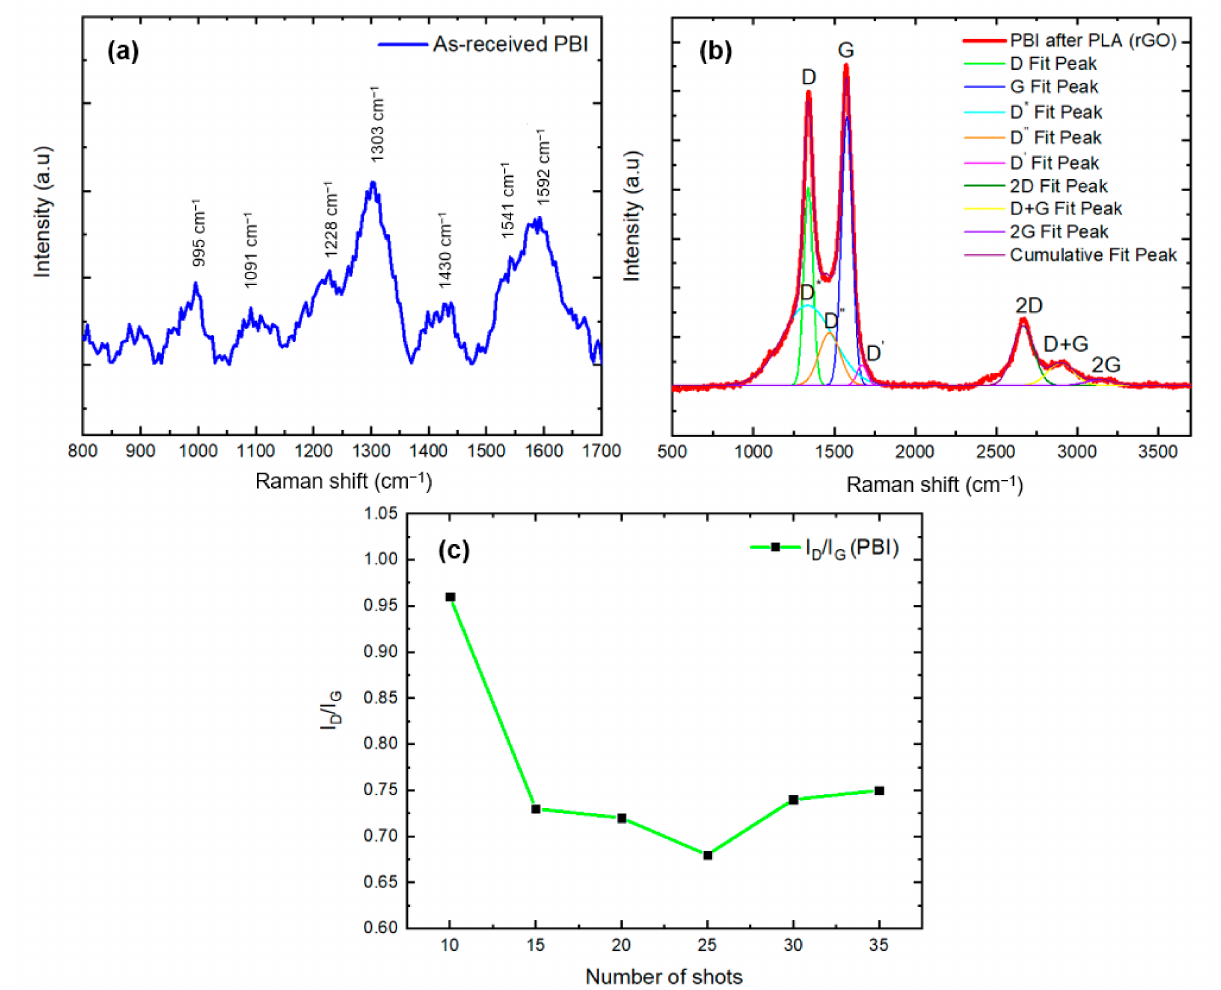
Figure 9. Raman spectra of ( a ) PBI before PLA and ( b ) PBI after exposure to multiple shots of the ArF laser at 0.7 ± 0.1 J·cm − 2 . ( c ) I D /I G ratio versus the number of laser